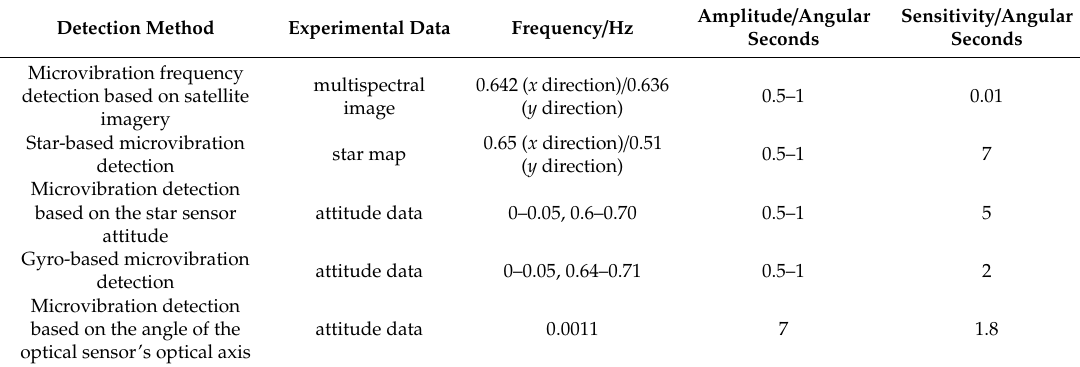
Table 5. Comparison of the results of five microvibration detection